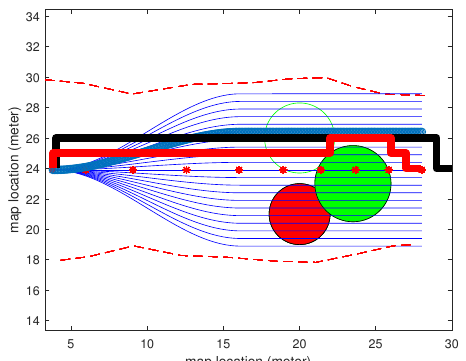
Figure 10. Comparison between basic A *, dynamic A * and the method in our paper. The obstacles are represented as circles. For obstacles that can cause collision risk, the color of the circles is filled with red; for those that can cause rollover risk, the color is set as green; and for those that are safe to pass through, transparent circles. The method under basic A * is shown by the solid red line; the method under dynamic A * is shown by solid black line; and the method we introduced in our paper is shown by the bold blue